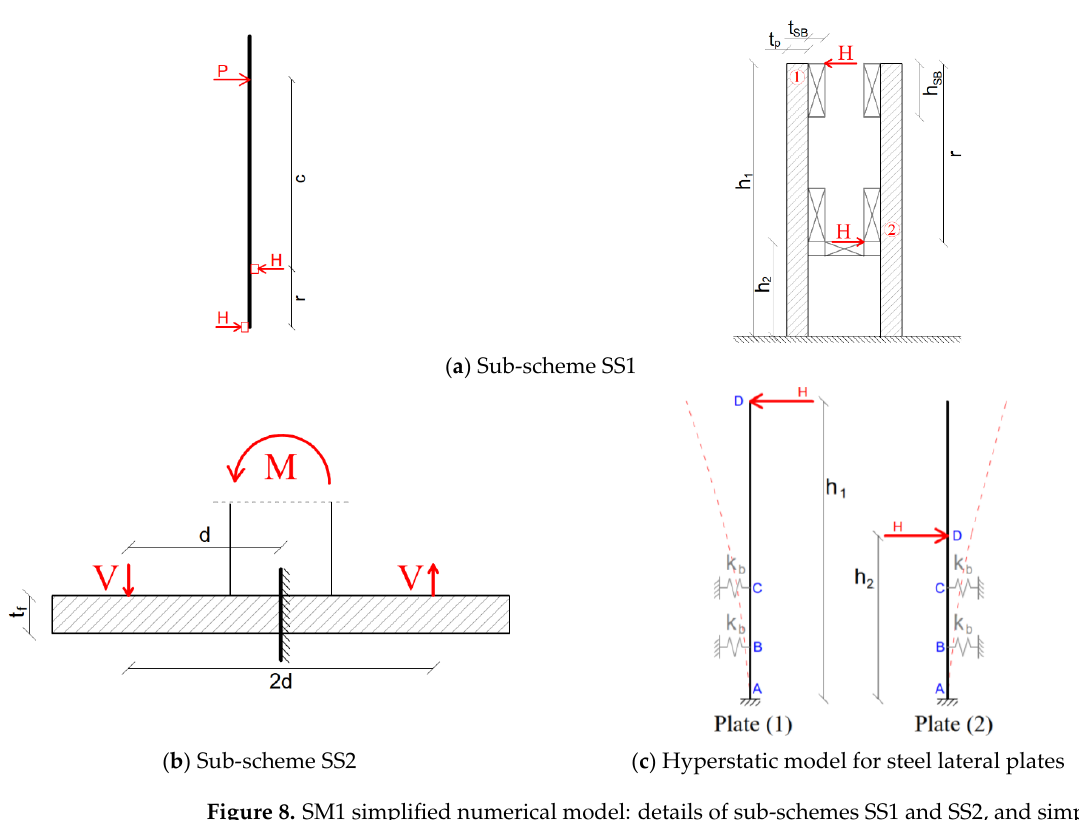
Figure 8. SM1 simplified numerical model: details of sub-schemes SS1 and SS2, and simplified local mechanical models to calculate the stiffness of steel lateral plates and the steel base flange for the LG balustrade in bending.